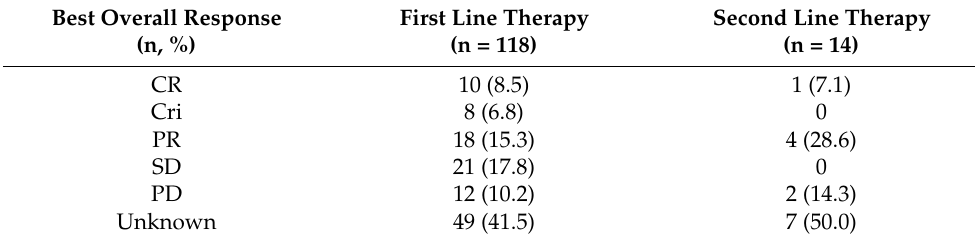
Table 4. Best overall response to first and second line